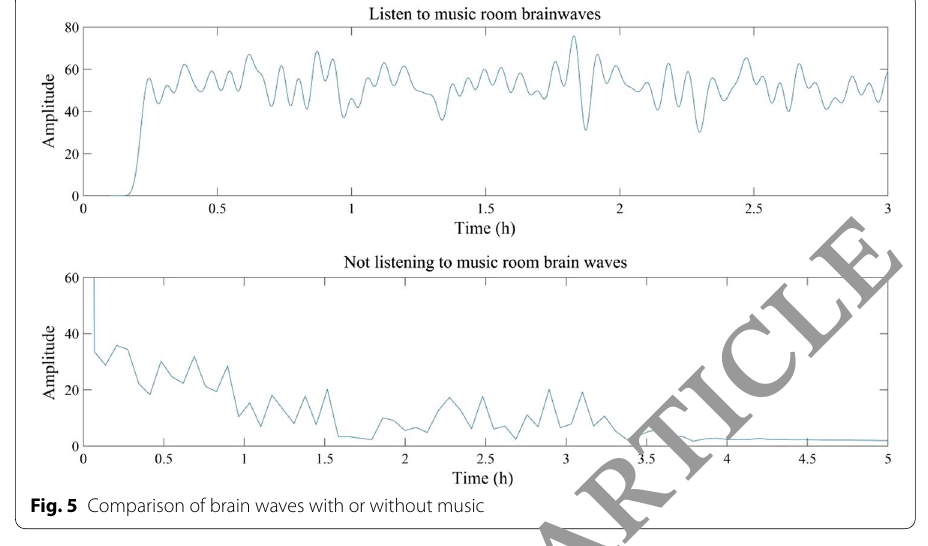
Fig. 5 Comparison of brain waves with or without music